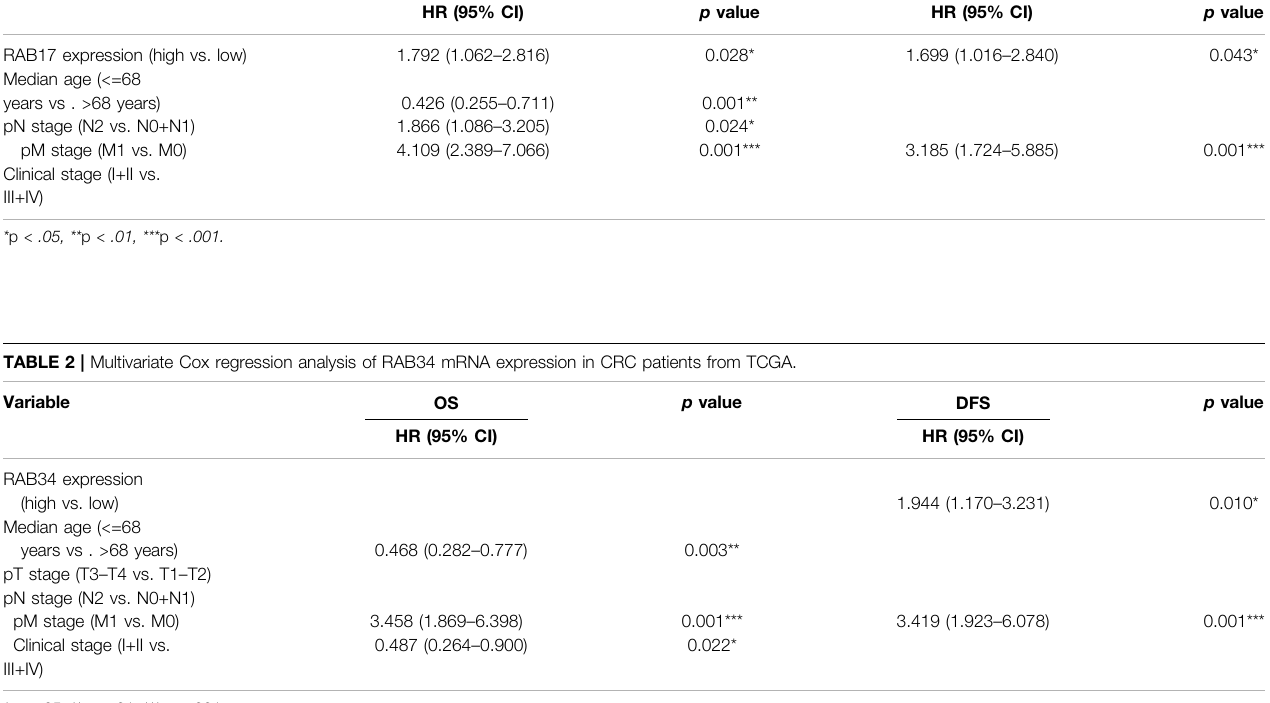
Table 8). Univariate and multivariate Cox regression analyses demonstrated that RAB17 was an independent prognostic factor for OS and DFS ( Table 1 ; Supplementary Table S9 ), and RAB34